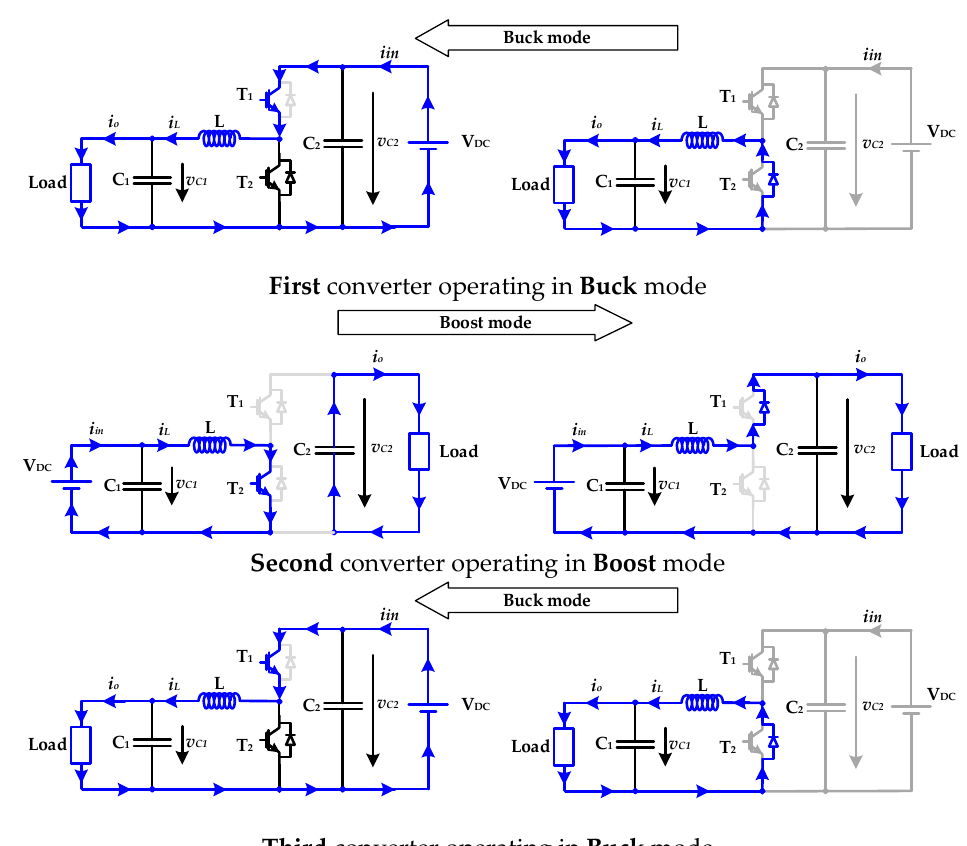
Figure 1. Description of the functionality of each DC–DC converter. Despite the same topology and components, each one will perform a different function.